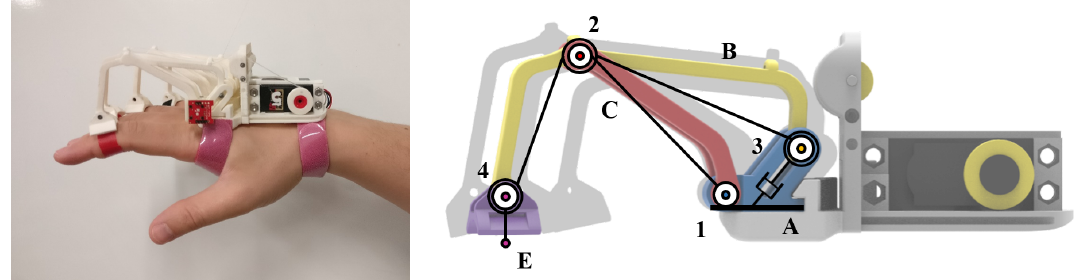
Figure 6. The figure shows, on the left, the final and current version of the exoskeleton prototype developed by the DIEF worn by a healthy subject and, on the right, the corresponding kinematic chain and CAD model. Colors and names (capital letters) of the components, and joints enumeration are reported as introduced in Section